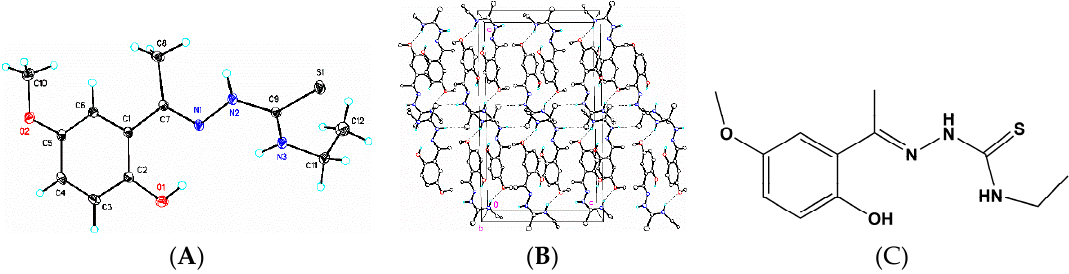
Figure 2. ( A ) ORTEP drawing of ( 2 ) showing the atom numbering scheme and 50% probability displacement ellipsoids of non-H atoms; ( B, C ) The molecular packing of ( 2 ) viewed along the b axis. Dashed lines indicate O–H … O intramolecular hydrogen bonds and weak N–H … S, N–H … O intermolecular interactions forming a 2D network structure. Hydrogen atoms not involved in hydrogen bonding have been removed for clarity.